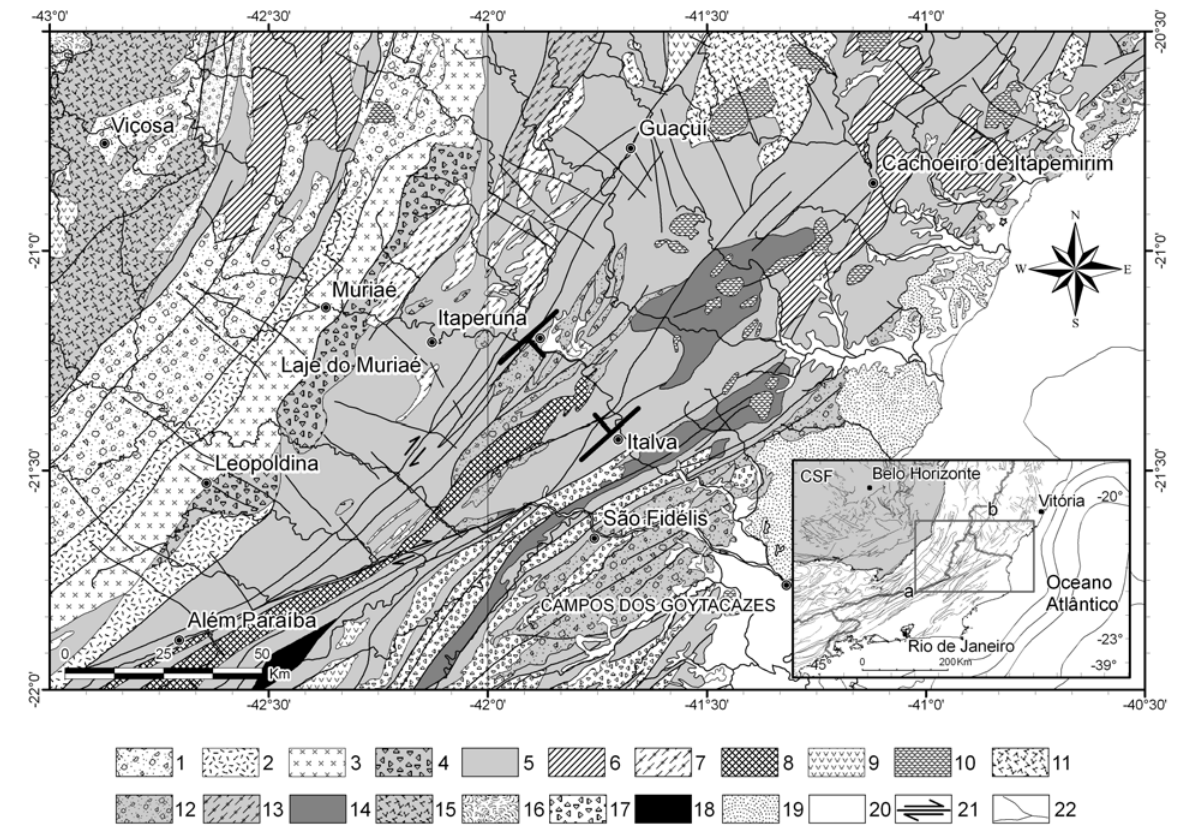
Fig. 1 – Geological map of northern region of the State of Rio de Janeiro with localization of the Italva-Itaperuna section (see Fig. 2). Sketch at right shows the location of the studied area and the regional structural pattern of the Central Mantiqueira Province with Além Paraíba Lineament (a) and Guaçuí Shear Zone (b). 1 – Juiz de Fora Complex; 2 – Quirino Suite; 3 – Muriaé Suite; 4 – Leopoldina Charnockitic Suite; 5 –